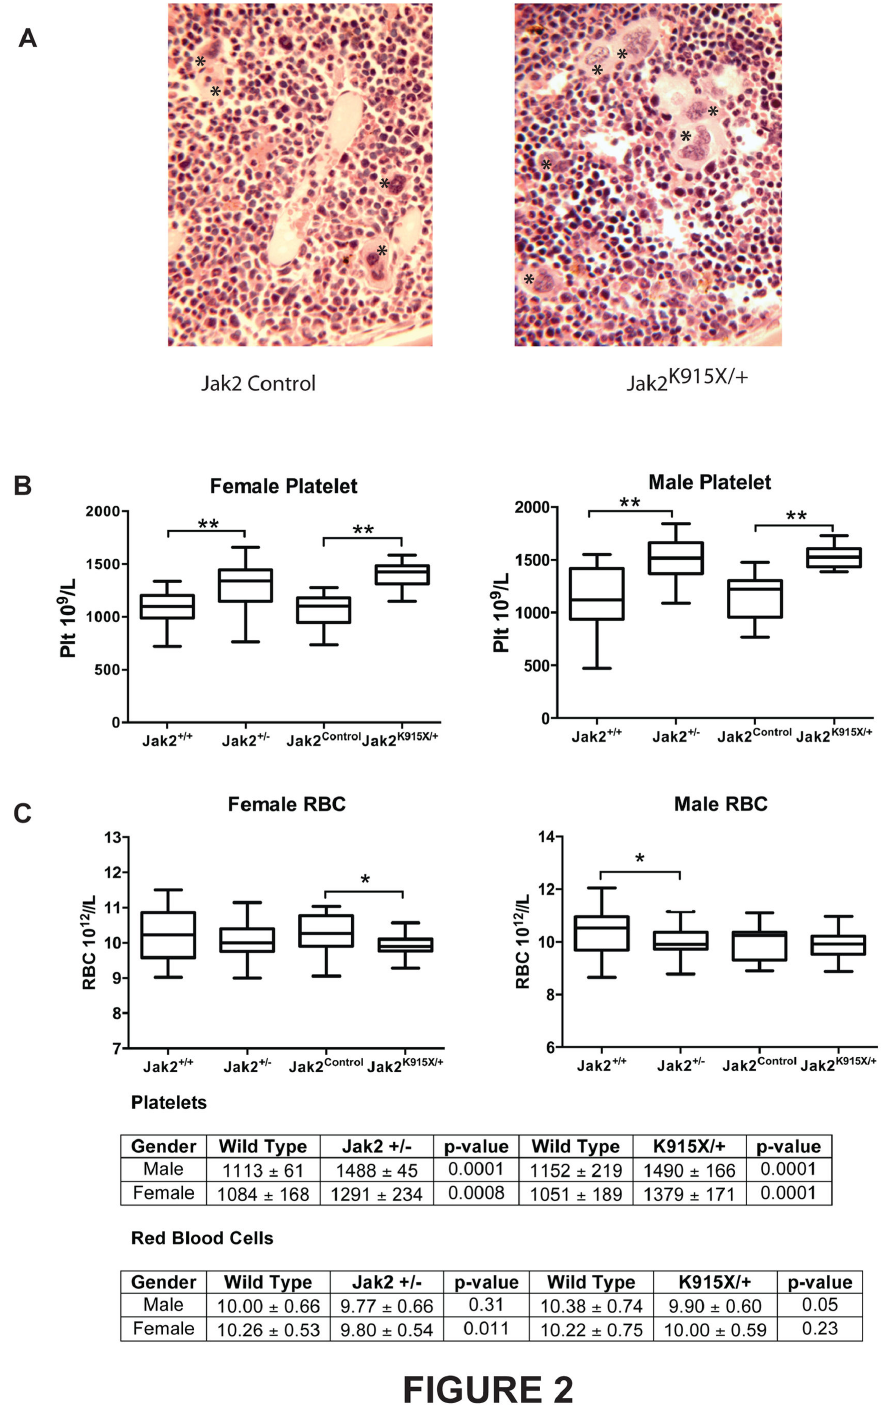
Figure 2. Jak2 K915X/+ mice have elevated megakaryocytes and platelets. (A) Bone marrow sections were prepared from 12 week Jak2 +/+ and Jak2 K915X/+ mice and stained with H and E. Representative sections are illustrated at 20x magnification. Megakaryocytes are indicated by an asterisk. (B) Platelets from male and female wild type, Jak2 +/- and Jak2 K915X mice at 8 wk of age were monitored. (C) Red blood cells were evaluated from male and female mice at 8 wk of age from WT, Jak2 +/- and Jak2 K915X/+ mice. Jak2 +/+ or JAK2 Control mice were littermate controls of Jak2 +/- or Jak2 K915X/+ breedings, respectively. Statistically significant differences between groups are denoted as *, p< 0.05 and **, p<0.0001. Each group has n=20-30. doi: 10.1371/journal.pone.0075472.g002 PLOS ONE |